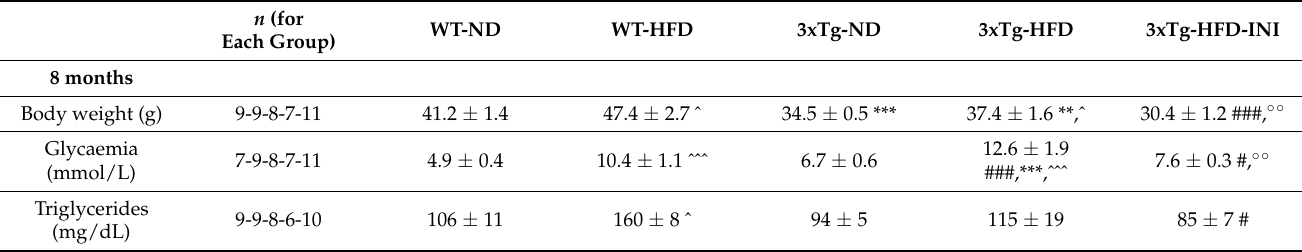
Figure 1. Fractional glucose extraction (GE) and glucose uptake (GU) in the liver ( A , B ), WAT ( C , D ), and BAT ( E , F ) in WT and 3xTg mice, fed ND or HFD, at age 8 and 14 months, are shown. Mean ± SEM shown. Different symbols are used for each within-age comparison, * p ≤ 0.05 vs. WT, ** p ≤ 0.01 vs. WT, *** p ≤ 0.001 vs. WT, ˆ p ≤ 0.05 vs. ND, ˆˆ p ≤ 0.01 vs. ND, # p ≤ 0.05 vs. WT-ND, ## p ≤ 0.01 vs. WT-ND, ◦ p ≤ 0.05 vs. 3xTg-HFD, ◦◦ p ≤ 0.01 vs. 3xTg-HFD. A line is used to identify statistically significant differences in between-age comparisons. Table 1. Bodyweight and circulating markers in study